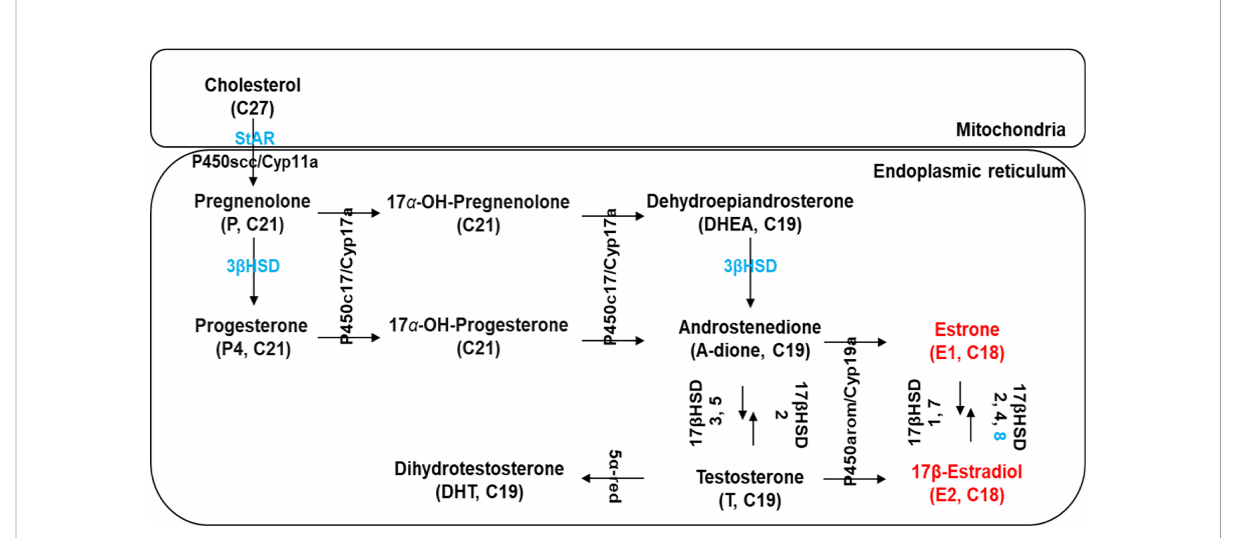
FIGURE 2 Schematic diagram modi fi ed from Janer and Porte (14) showing the presence of several putative steroidogenic genes (marked in blue) in C. sapidus known to be involved in vertebrate steroidogenesis. Estrogens, 17 b -estradiol (E2) and estrone (E1), are marked in red. StAR, StAR-related lipid transfer protein; P450scc/Cyp11a, P450 side-chain cleavage; 3 b HSD, 3 b -hydroxysteroid dehydrogenase; 17 b HSD, 17 b -hydroxysteroid dehydrogenase; P450c17/Cyp17a1, 17 a -hydroxylase/17, 20-lyase; P450arom/Cyp19a, P450 aromatase; 5 a -red, 5 a